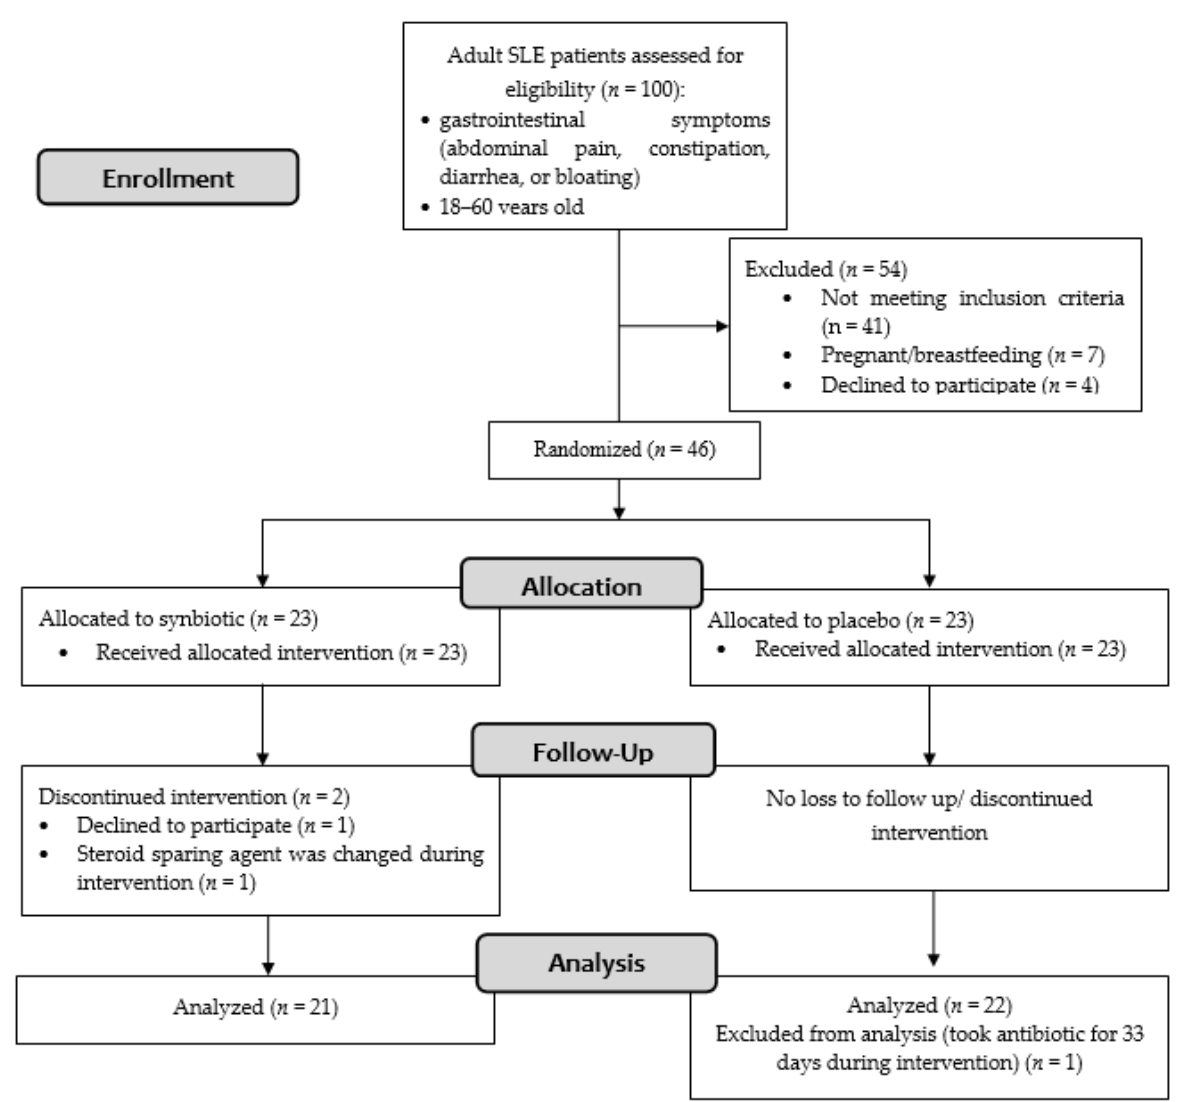
Figure 1. Flowchart diagram of the study . Table 1. Baseline characteristics.